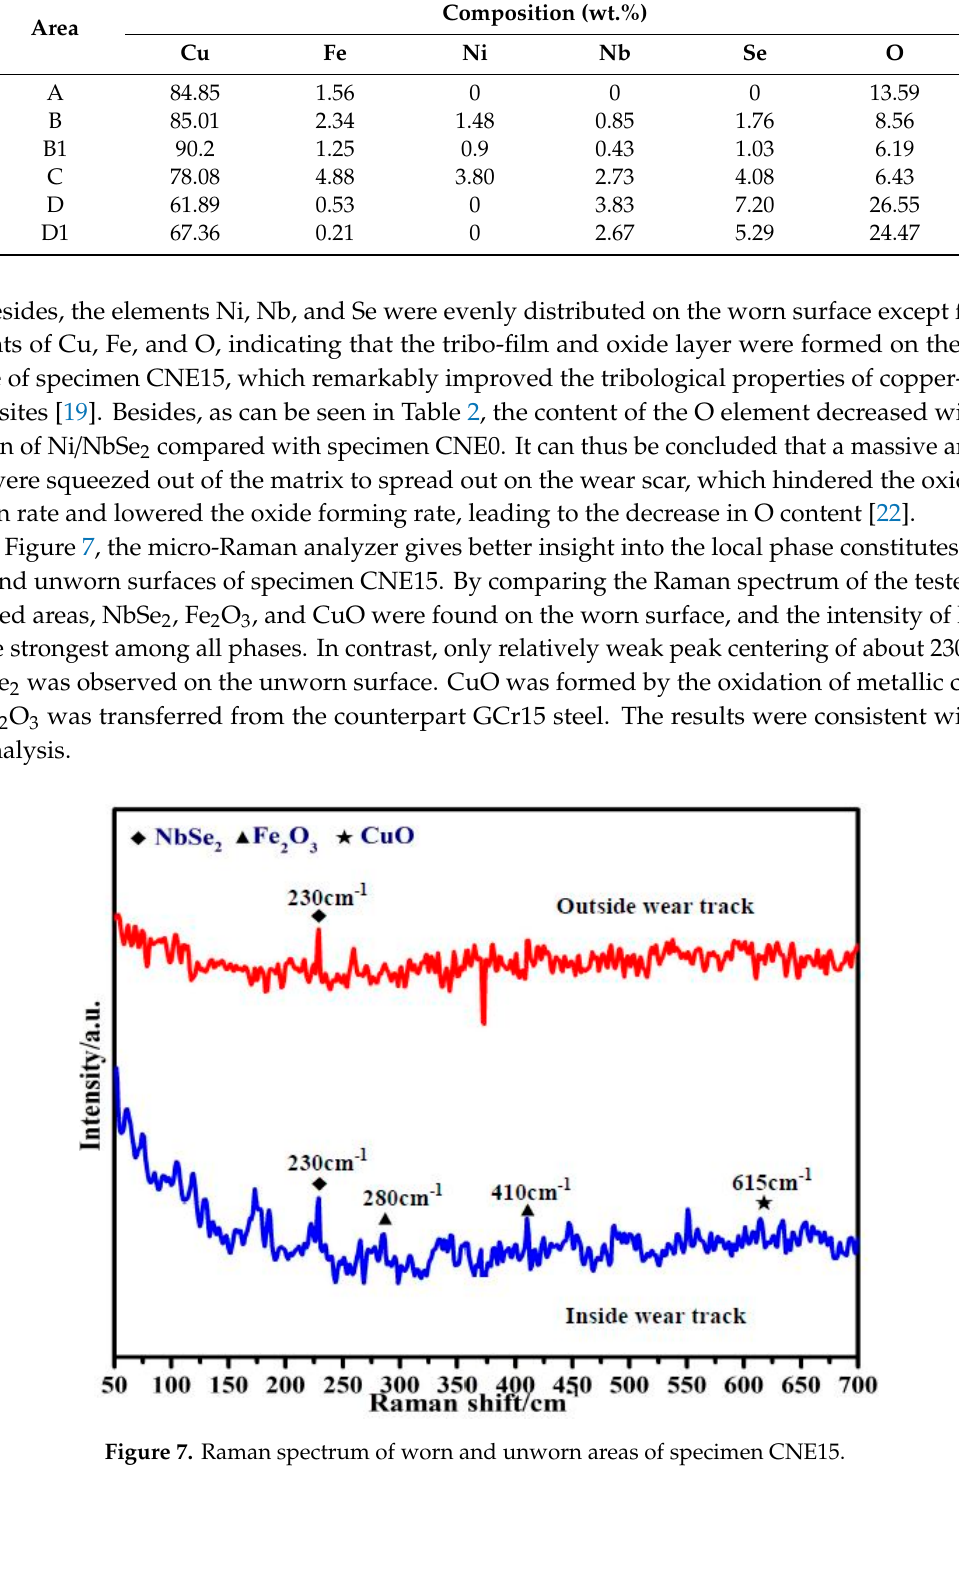
Table 3. EDS of worn surface of Cu / Ni / NbSe 2 composites (mass fraction / wt.%).